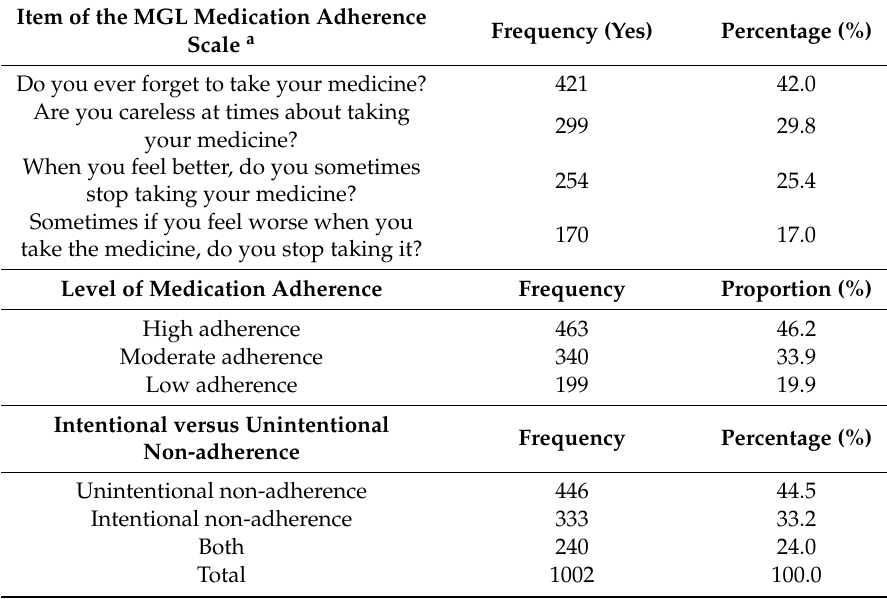
Table 2. Details of respondents’ self-reported medication non-adherence status.